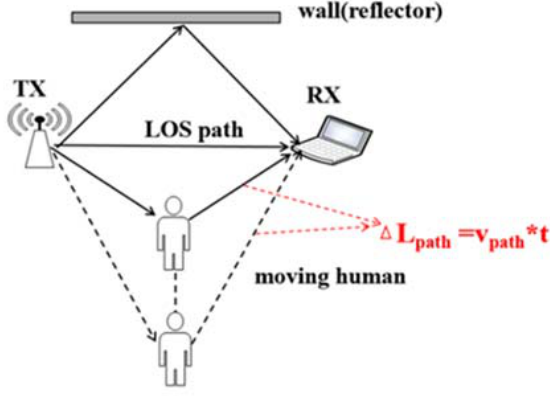
Figure 5. Path length change due to the human movement.